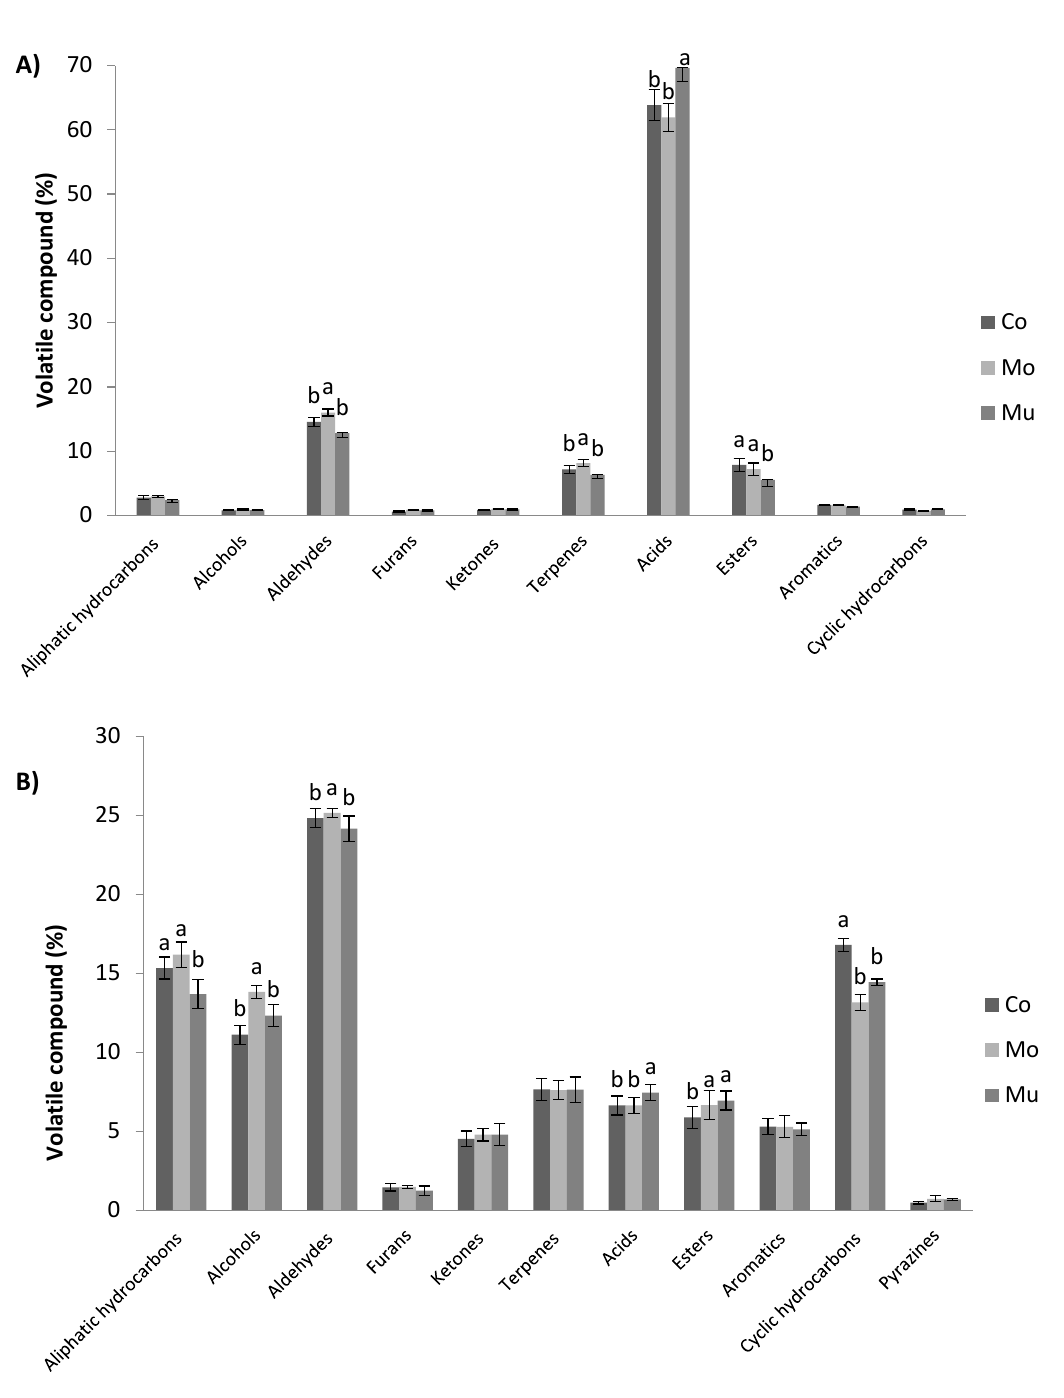
Figure 2. Volatile compounds of dry-cured ( A ) and cooked ( B ) sausages as affected by enrichment with omega-3 polyunsaturated fatty acids ( ω -3 PUFA) (control: dark gray; enriched with multilayered fish oil microcapsules: medium gray; enriched monolayered fish oil microcapsules: light gray) classified according to chemical families. Values are expressed as the average percentage of each family. Bars with different letters (a, b) within the same formulation show significant differences ( p < 0.05) due to enrichment effect (Co vs. Mo vs. Mu).